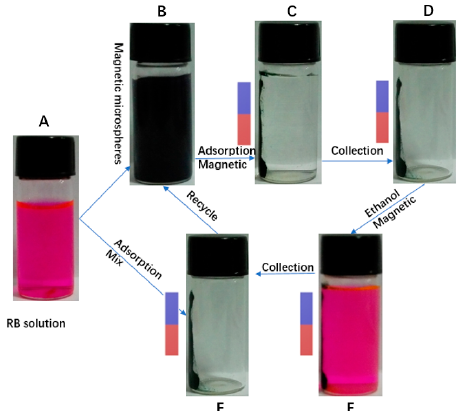
Figure 9. Schematic illustration of magnetic separation of RB from aqueous solution, and regeneration